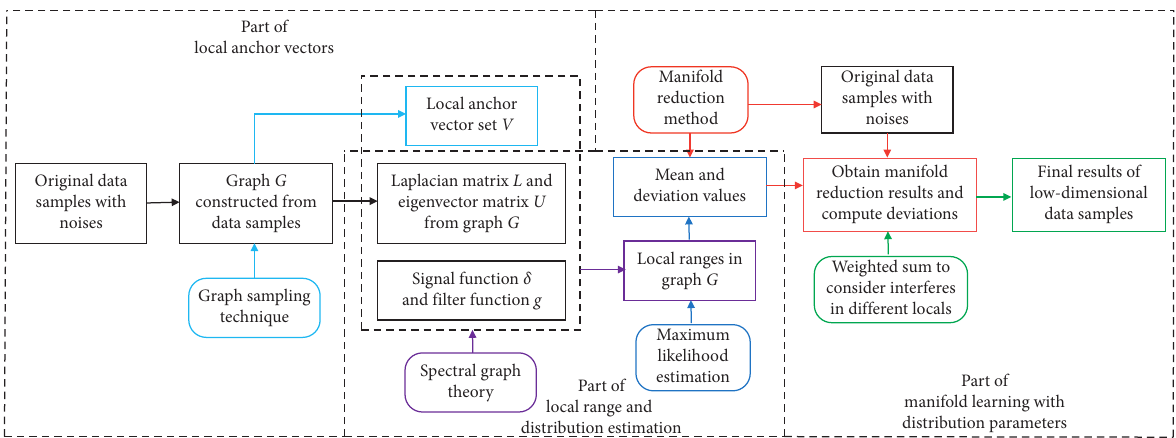
Figure 2: A schematic illustration of the whole proposed framework of manifold dimension reduction of noisy